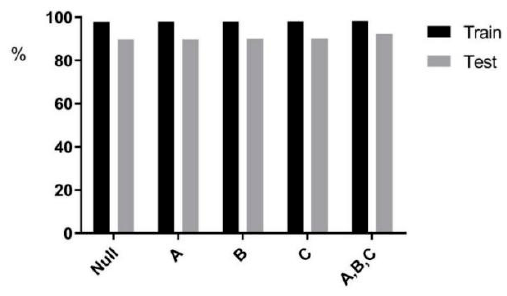
Table 3. A priori information on the model impact.